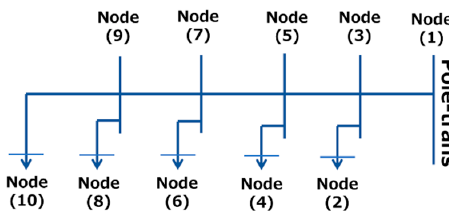
Figure 4. Network consisting of five consuming nodes.